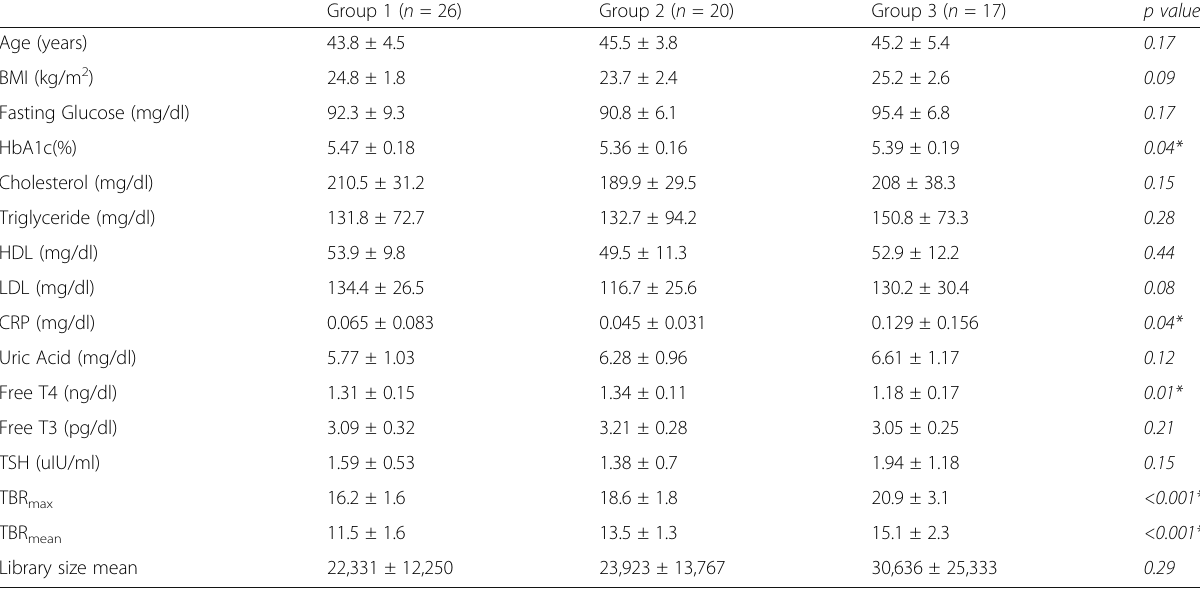
Table 1 Demographic, laboratory and TBR data by visual grade of intestinal FDG